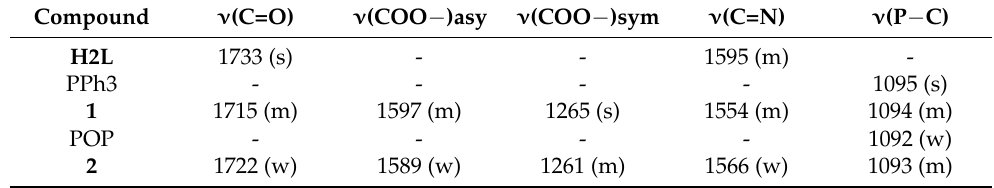
Table 1. Characteristic absorptions (cm − 1 ) in the IR spectra of ligand H 2 L and complexes 1 and 2 *.